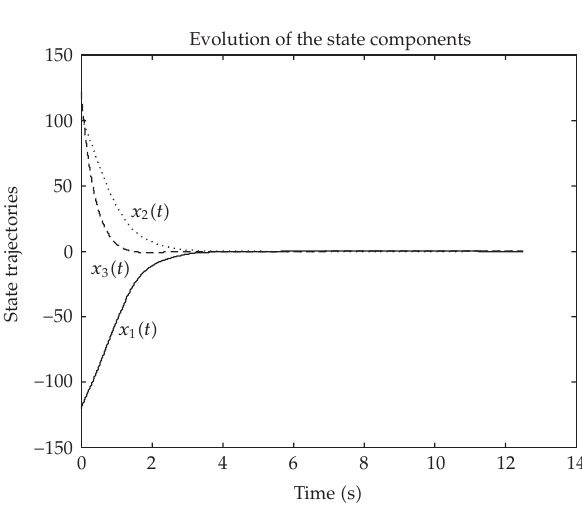
Figure 7: Evolution of the state-space components for h (cid:8) 0 . 1 second.